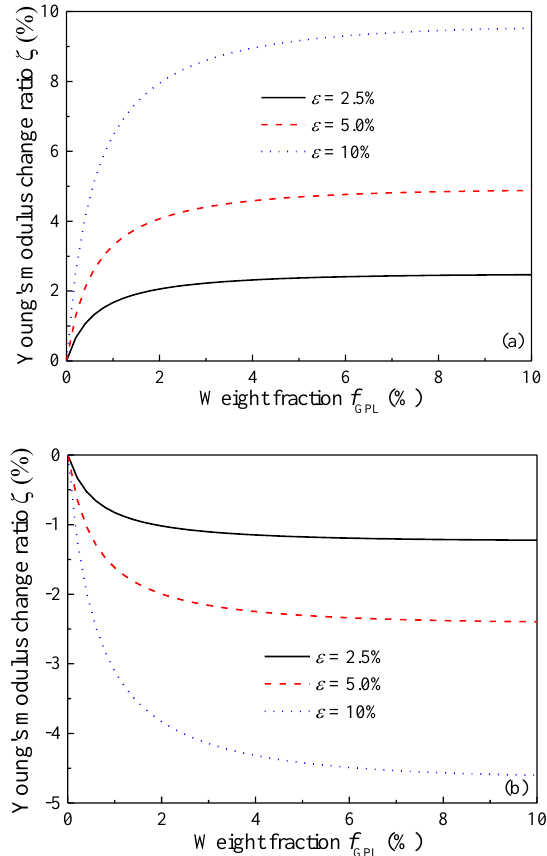
Figure 6. Young’s modulus change ratio of GPL/Epoxy nanocomposites ( a ) stretching direction; ( b ) transverse direction.